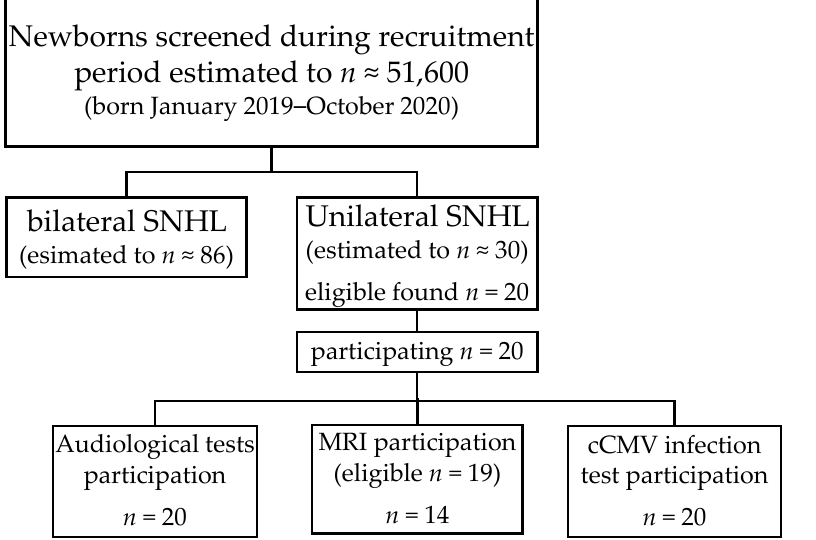
Figure 1. Estimated and included number of participants. Estimated numbers are based on previous universal neonatal hearing-screening results from Region Stockholm ([2], >30,000 screened, 98% coverage rate), and the documented number of newborns during 2019 and 2020 in Region Stockholm [46]. One subject was born with a heart anomaly, which is the reason for 19 subjects eligible for MRI. cCMV = congenital cytomegalovirus; MRI = magnetic resonance imaging; SNHL = sensorineural hearing loss.